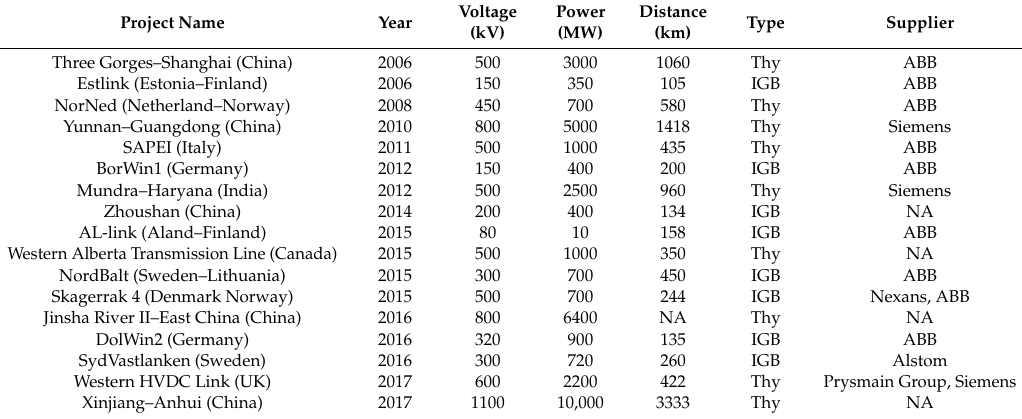
Table 1. List of HVDC projects in di ff erent